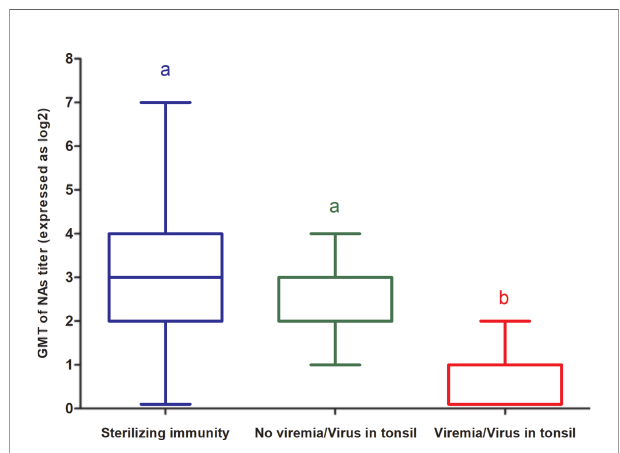
FIGURE 3 | GMT of NAs against the challenge virus on D70 of the experiment (i.e day of challenge) in groups in which sterilizing immunity was observed, groups in which viremia was not detected but the challenge virus was occasionally detected in tonsils and groups in which viremia was detected upon challenge of immunized pigs in experiment A. Each box represents 25 – 75% of observation. Whiskers above and below of each box represent the lowest datum still within 1.5 interquartile range (IQR) of the lower quartile, and the highest datum still within 1.5 IQR of the upper quartile. Solid line within each box is the median. Statistically signi fi cant differences are highlighted by different